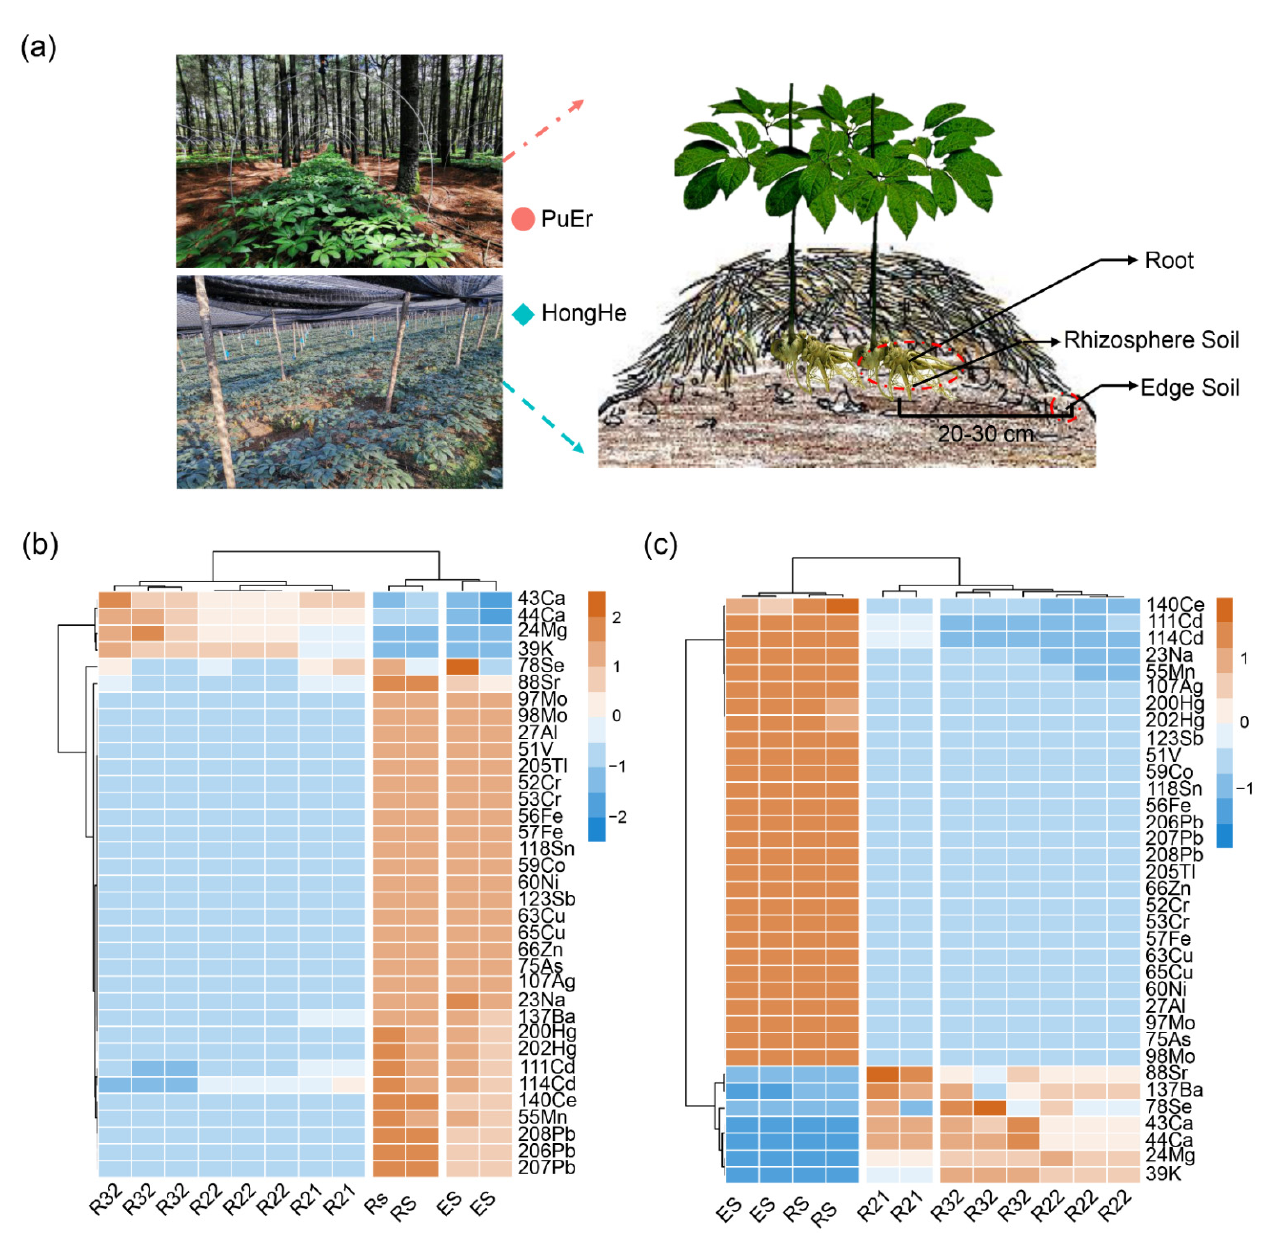
Figure 1. The accumulation dynamics of elements during the growth of P. notoginseng . ( a ) Growth environment of P. notoginseng in different cultivation models, and specific sampling locations of P. notoginseng roots, ehizosphere, and edge soil. ( b ) The multi-element determination result of P. notoginseng and soil in PuEr bases. ( c ) The multi-element determination result of P. notoginseng and soil in HongHe bases. RS: rhizosphere soil; ES: edge soil; R21: root of P. notoginseng collected in August 2019; R22: root of P. notoginseng collected in November 2019; and R32: root of P. notoginseng collected